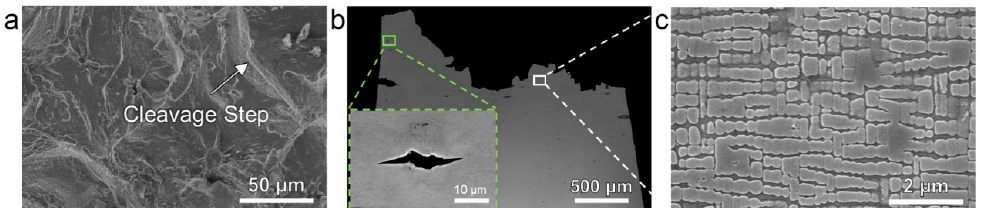
Figure 8. Microstructure evolution of 0Ta6Al2Ti, 3Ta6Al1Ti, Ta6.4Al2Ti, and 3Ta6.4Al1Ti alloys af- ter thermal exposure at 1050 °C for up to 500 h. The microscopic observations identify no TCP phase formation at different exposure times in all alloys.